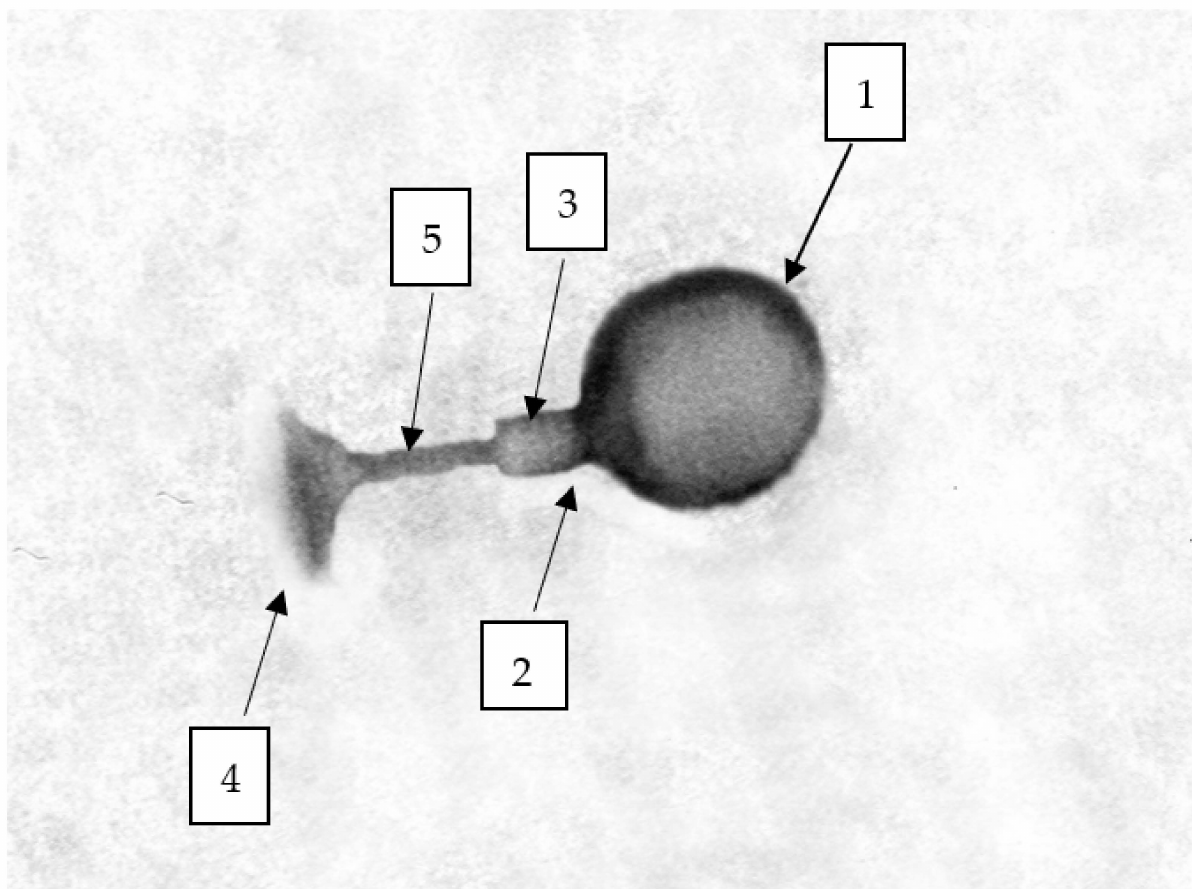
Figure 4. Morphology of the Enterobacter phage KKP 3262 (1—head, 2—neck, 3—contractile sheath, 4—baseplate, 5—tail